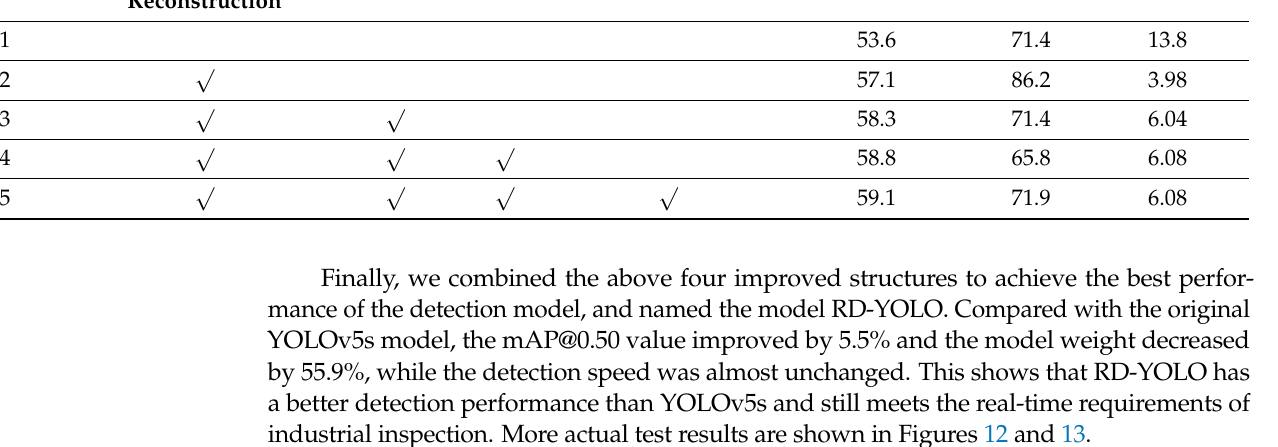
Table 4. Comparison of ablation experiment results.